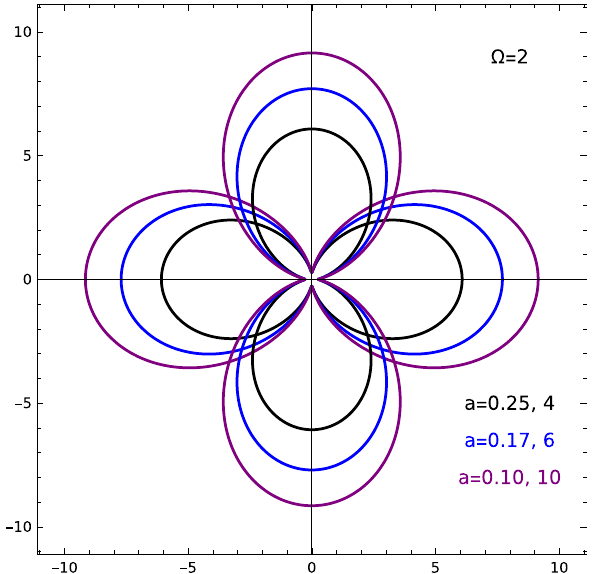
Figure 4. Static dipole polarizabilities of Mott-Wannier exciton in first excited state for different levels of anisotropy of confinement; left (right) column listing anisotropy parameters a corresponds to the deformation along x (y) axis. Material parameters of MoS 2 monolayer has been used: µ = 0.28 in units of free electron mass and ε = 5 . The value of polarizability for any direction is equal to the distance of the point on the curve from origin. Polarizabilities are given in units of a 3 0 , where a 0 ≃ 0.529Å is the Bohr radius.